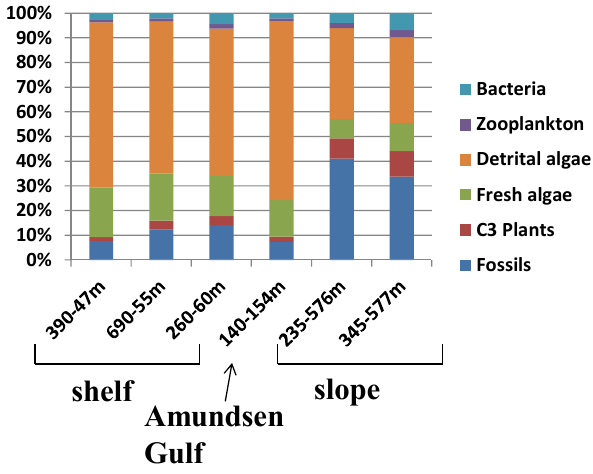
Fig. 8. Relative contributions of OM constituents in the sedi- ments from the Mackenzie Shelf, Amundsen Gulf and slope. The molecular biomarkers were separated into the following compo- nents: fossil (UCM, and petroleum hydrocarbons), fresh/labile al- gal (PUFA, phytol, IP 25 , n -C 21 : 6 , C 28 1 5 , 24 ( 28 ) , C 29 1 5 , 24 ( 28 ) ) , refractory/detrital algal (SCFA, SCMUFA, rest of sterols, biogenic alkanes, SCOH, SCMUOH), zooplankton (LCMUFA, LCMUOH and cholesterol), bacterial (branched FA, branched alcohols and C 18 : 1 ω 7 FA) and C 3 terrestrial plants (LCFA, LCOH, wax n -alkanes and sitosterol (except for site